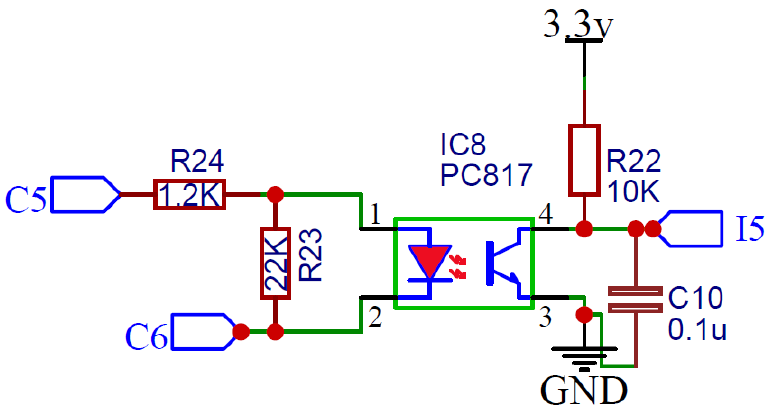
Figure 4. Voltage measurement